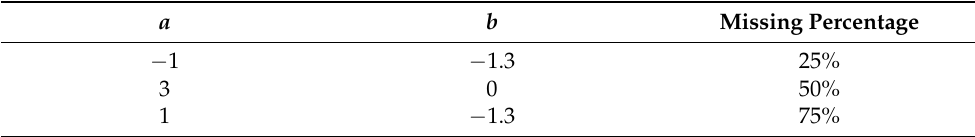
Table 1. Settings for Generating MNAR Data in the Experiments.